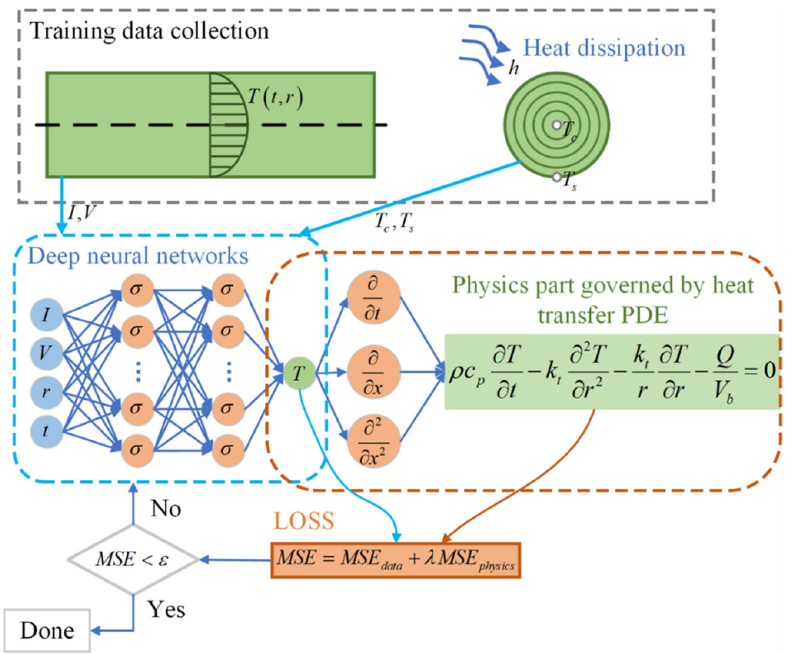
Figure 7. Framework of temperature distribution estimation using PINN: Measured temperature data at the battery surface and core are used for training the data ‐ driven model (e.g., based on deep